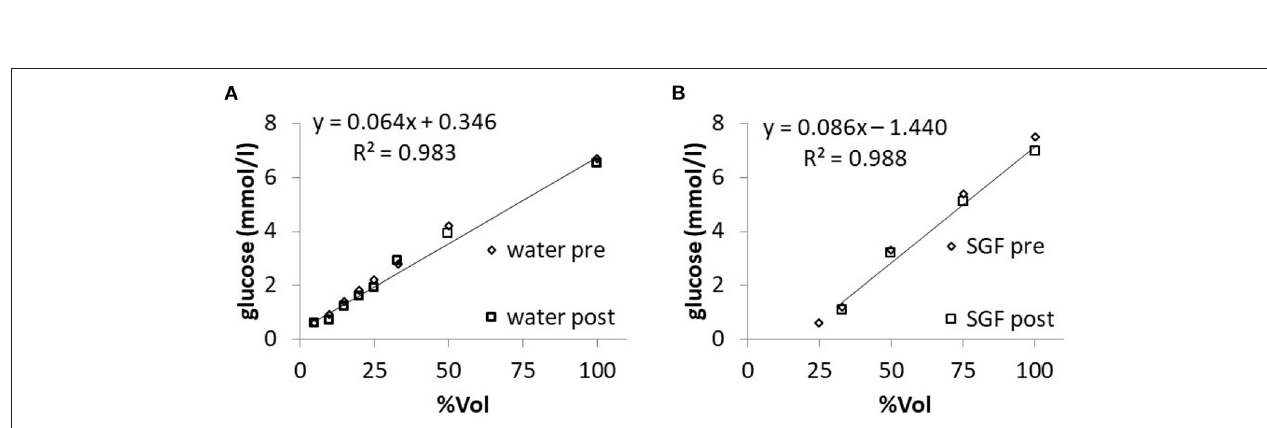
FIGURE 4 | Relationship between measured glucose concentration and nutrition formula (Fresubin Original Fiber) concentration in water (A) or in SGF (B) before (“pre”) and after (“post”) 240-min of incubation in the respective medium; single measurements. Regression lines and equations are given for the “post” data. The normalized standard error of the slope of the regression line was 5.4% for (A) and 7.9% for (B) before